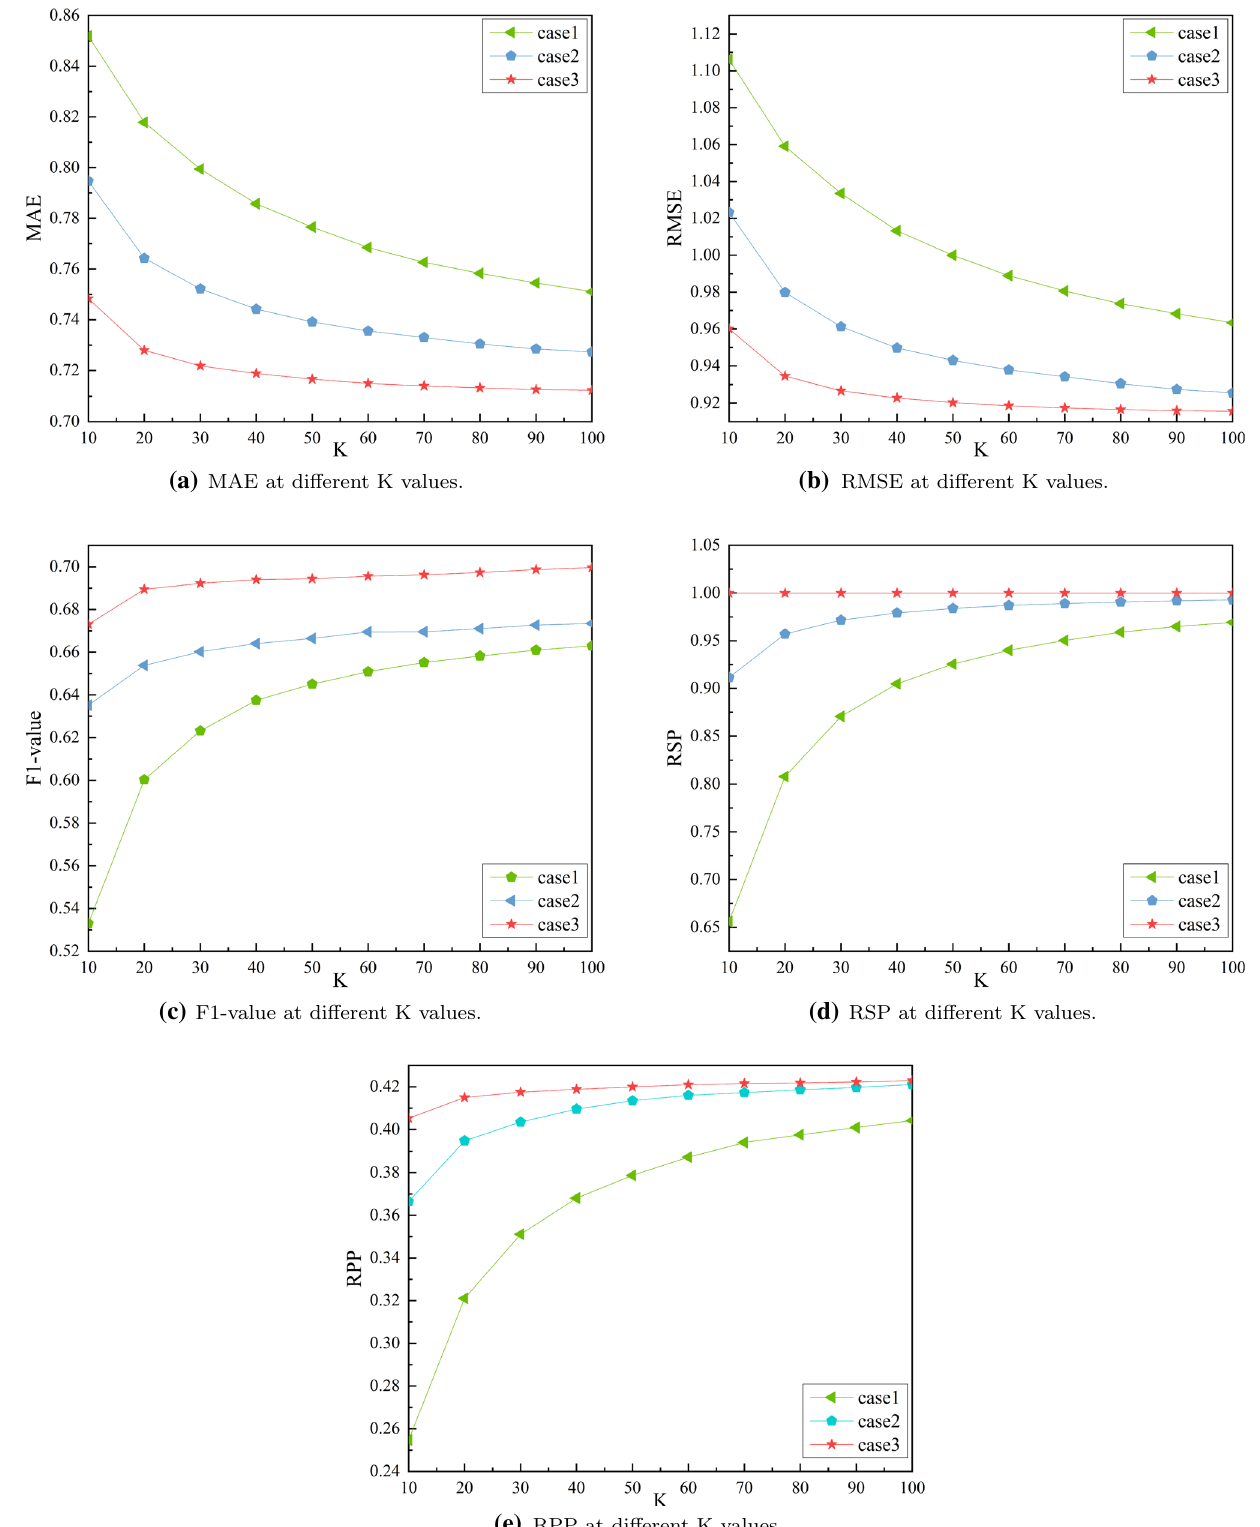
Fig. 2 Performance results in ML-1